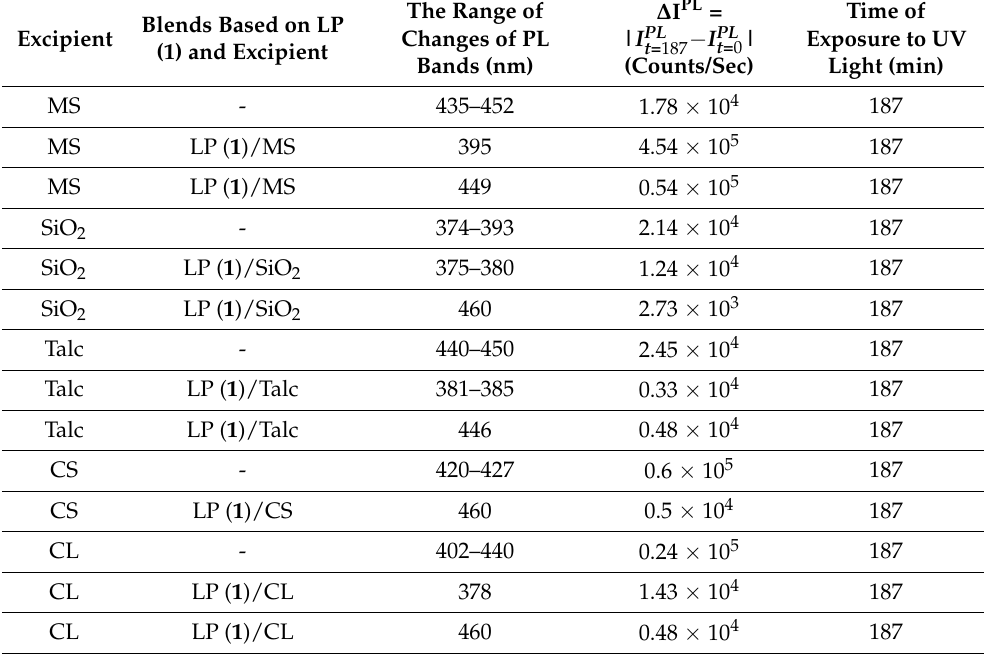
Table 1. The main variations of PL spectra of excipients and their mixture with LP ( 1 ) during to exposure to UV